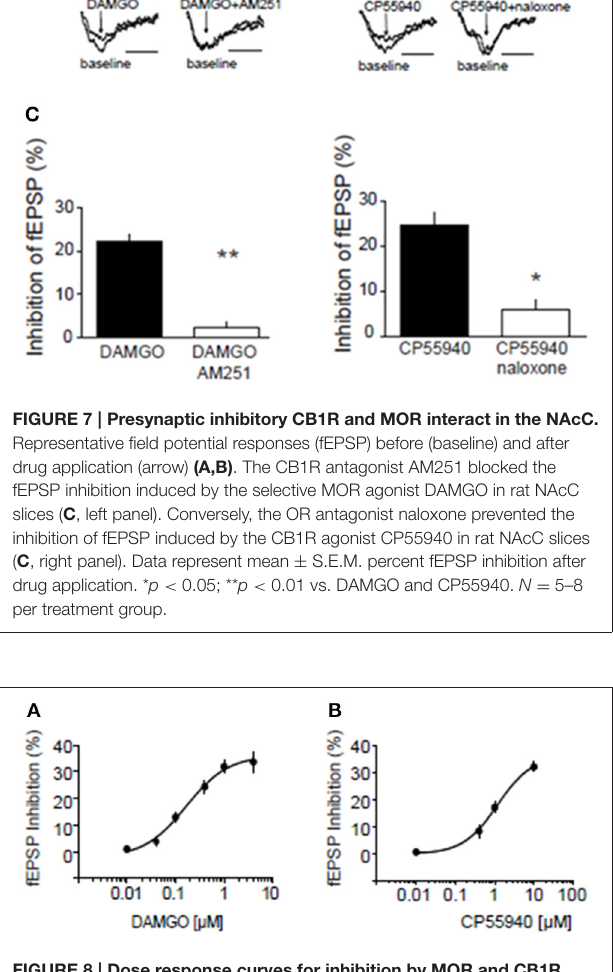
FIGURE 8 | Dose response curves for inhibition by MOR and CB1R agonists at excitatory NAcC synapses. Dose response curve for the MOR agonist DAMGO (A) and for the CB1R agonist CP55940 (B) in rats. Error bars represent S.E.M. N = 3–5 per doses.